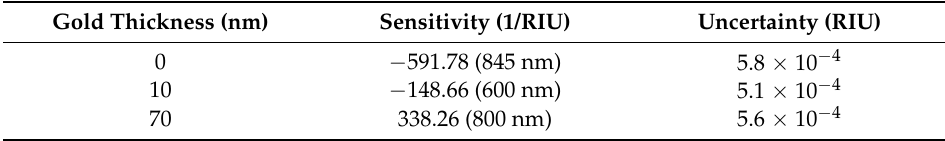
Table 2. Summary of the biosensors sensitivities and maximum expanded uncertainties (95% confidence level) in the Setup